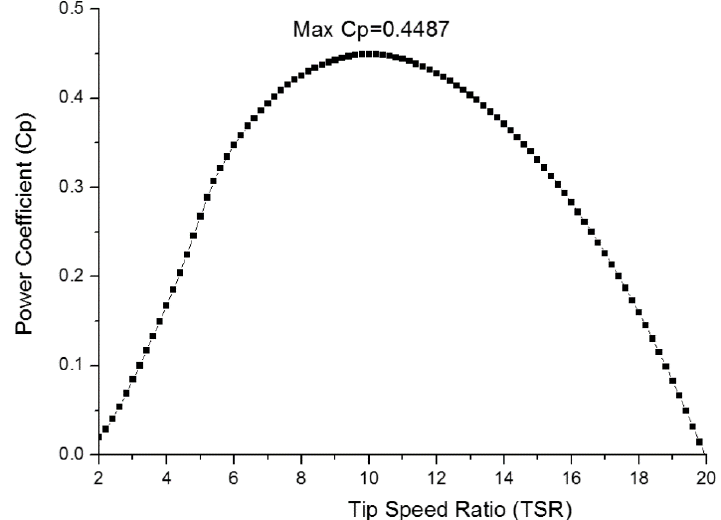
Figure 5. Power coe ffi cients in terms of the tip speed ratio Figure 5. Power coefficients in terms of the tip speed ratio (TSR). Figure 5. Power coefficients in terms of the tip speed ratio (TSR).